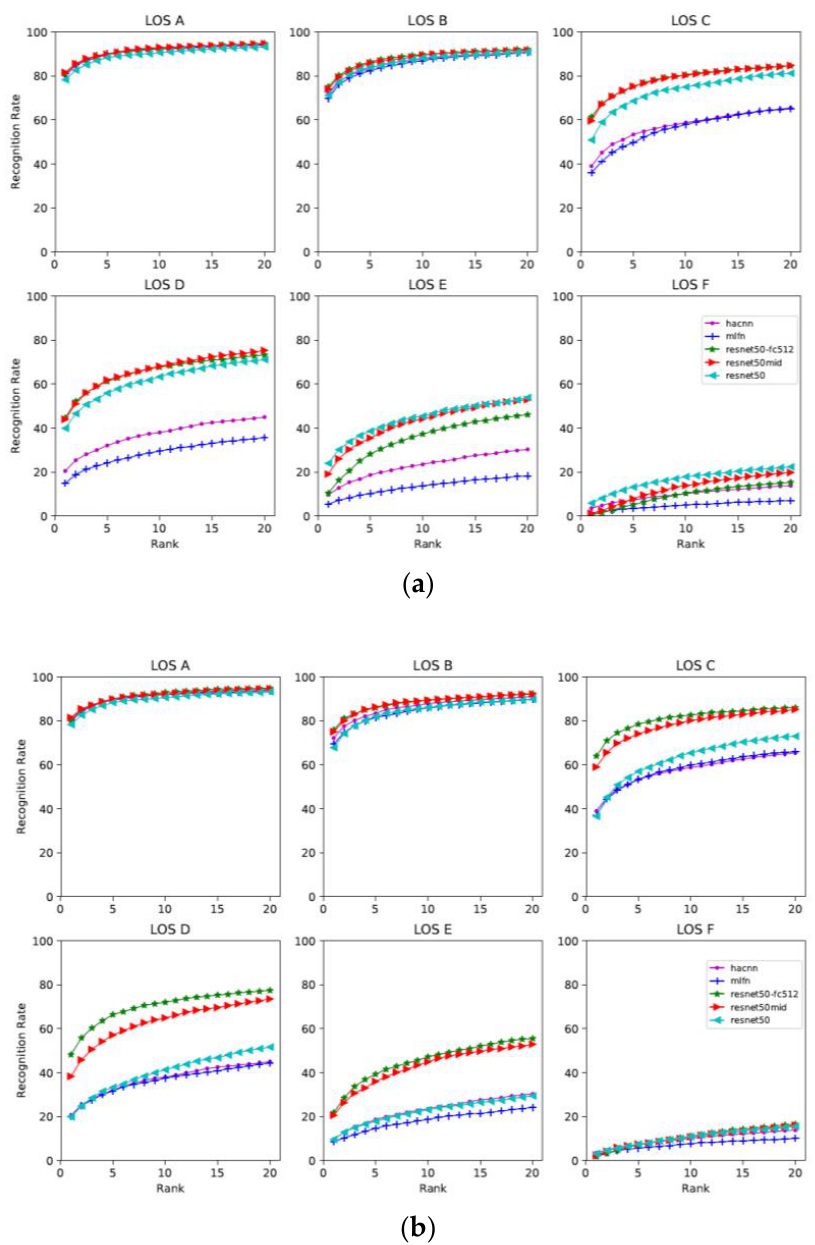
Figure 5. The CMC curve of the image-based methods under different congestion levels. ( a ) Pair-wise network. ( b ) Triplet network.